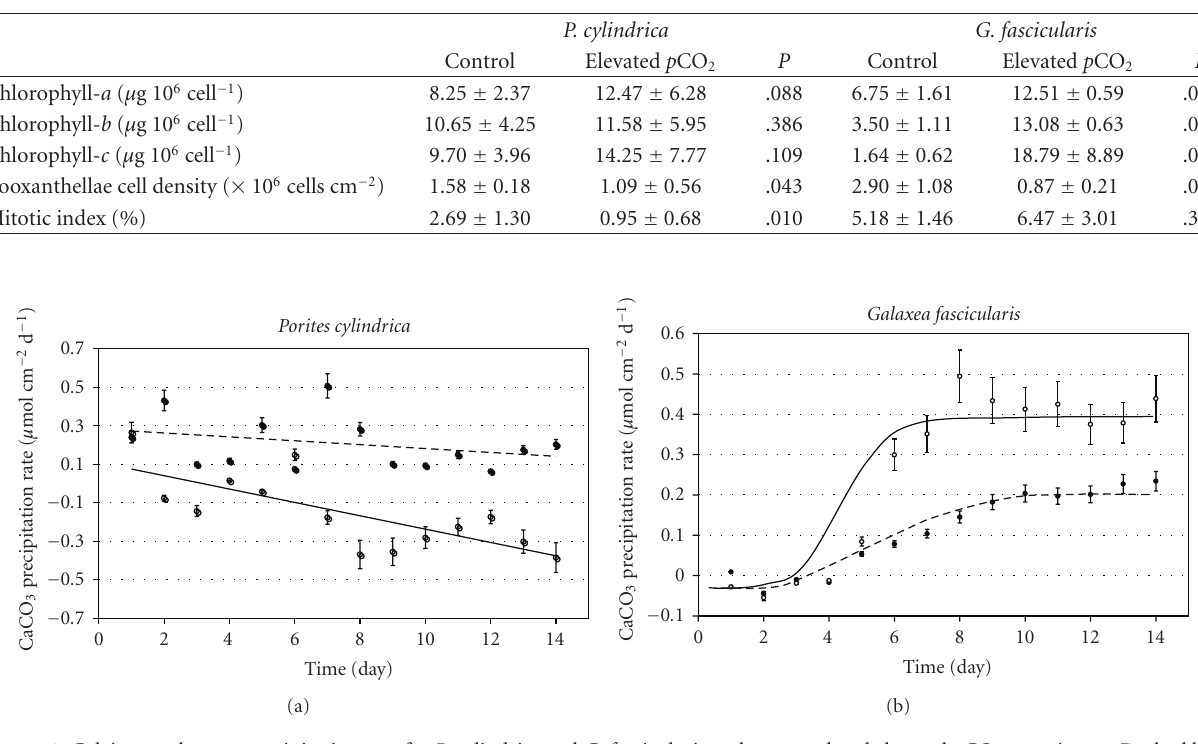
Figure 2: Calcium carbonate precipitation rate for P. cylindrica and G. fascicularis under control and elevated p CO 2 experiment. Dashed line and solid circle indicate control while solid line and open circle indicate elevated p CO 2